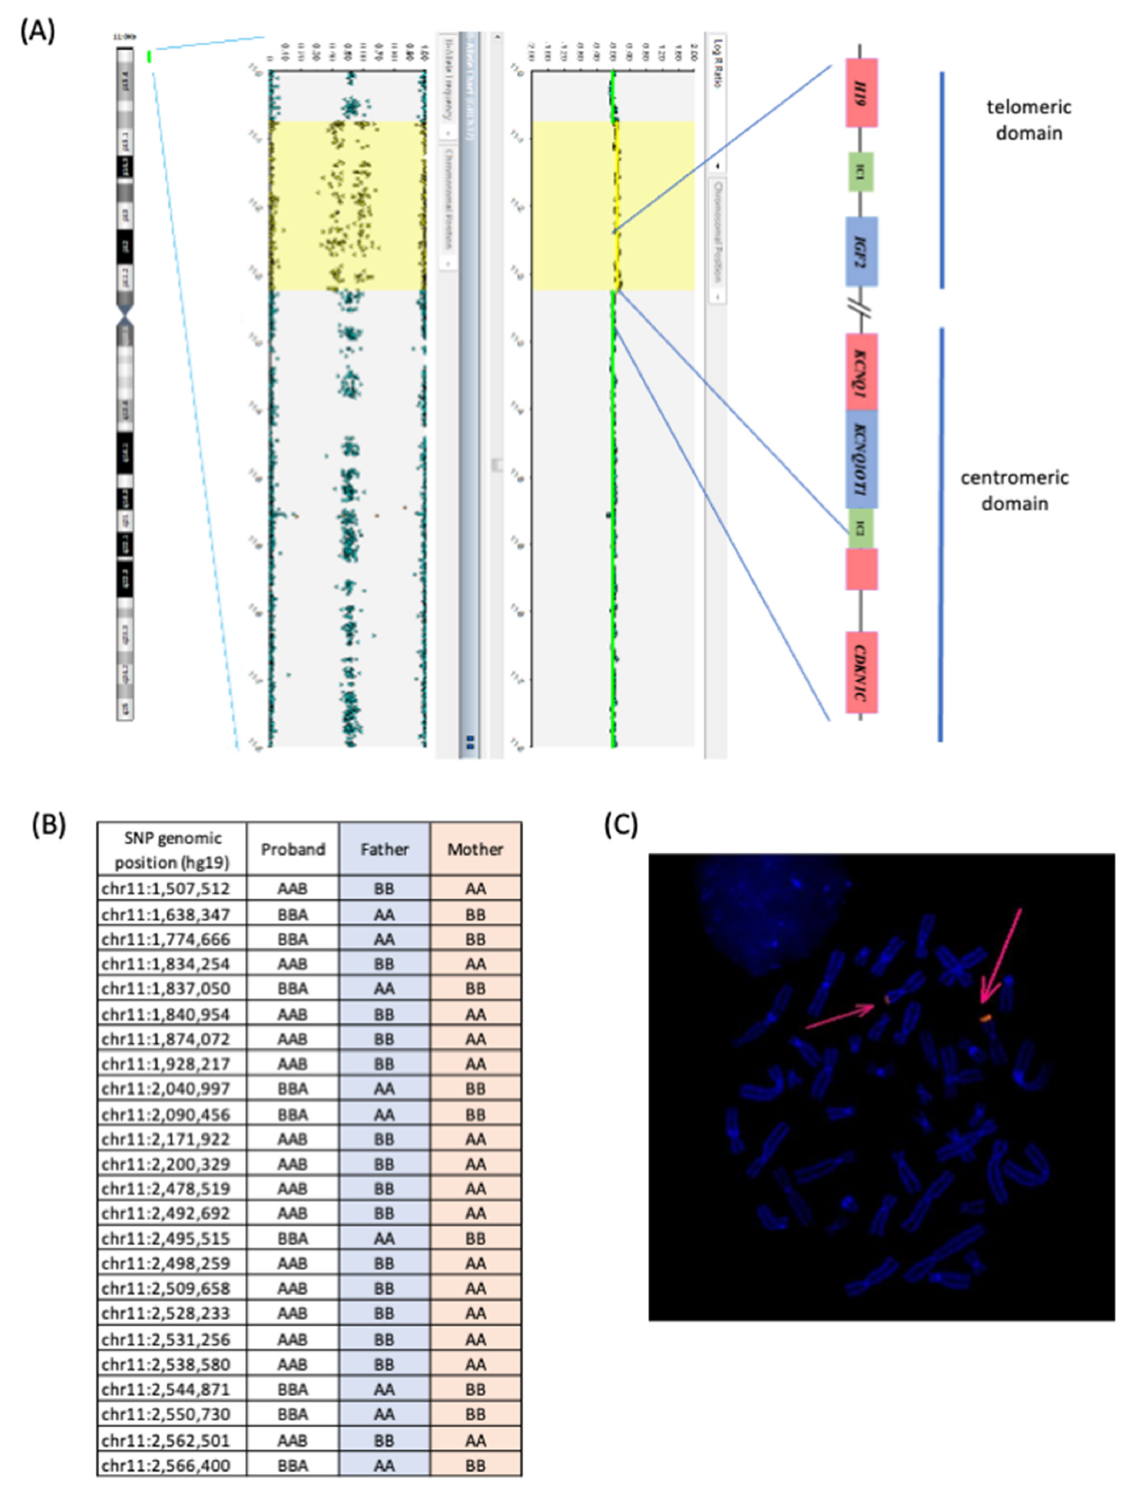
Figure 2. Genetic characterization of the 11p15 duplication in proband 1. ( A ) SNP-array analysis showing a mosaic duplication (in yellow) extending from 795,147 to 2,712,286 of chromosome 11 (rsa[GRCh37] 11p15.5(795,147_2,712,286) × 3 [0.5]). ( B ) Informative SNPs of the TRIO mapping in the duplicated region revealed the maternal origin of the duplication. ( C ) FISH analysis on methaphases and nuclei showing the probe signal mapping only at chromosomes 11 (pink arrows). The signal was detectable in about 50% of the